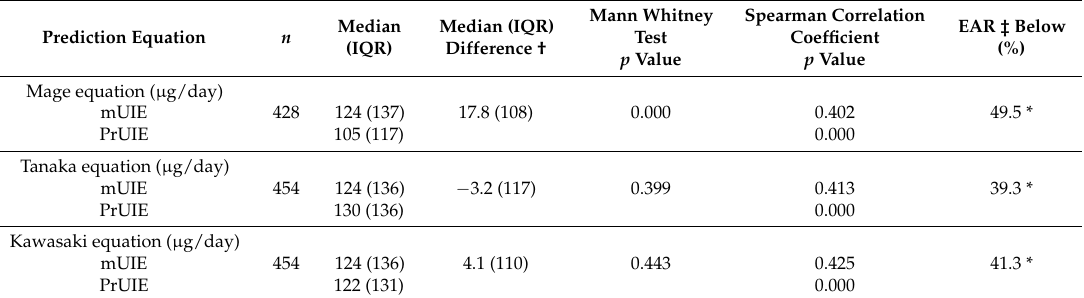
Table 4. Difference between measured and predicted 24 h urinary iodine excretion (UIE), SAGE South Africa Wave 2